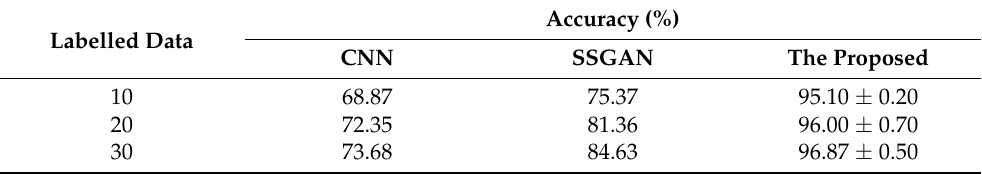
Table 3. Classification accuracy of samples with different numbers of labelled data.